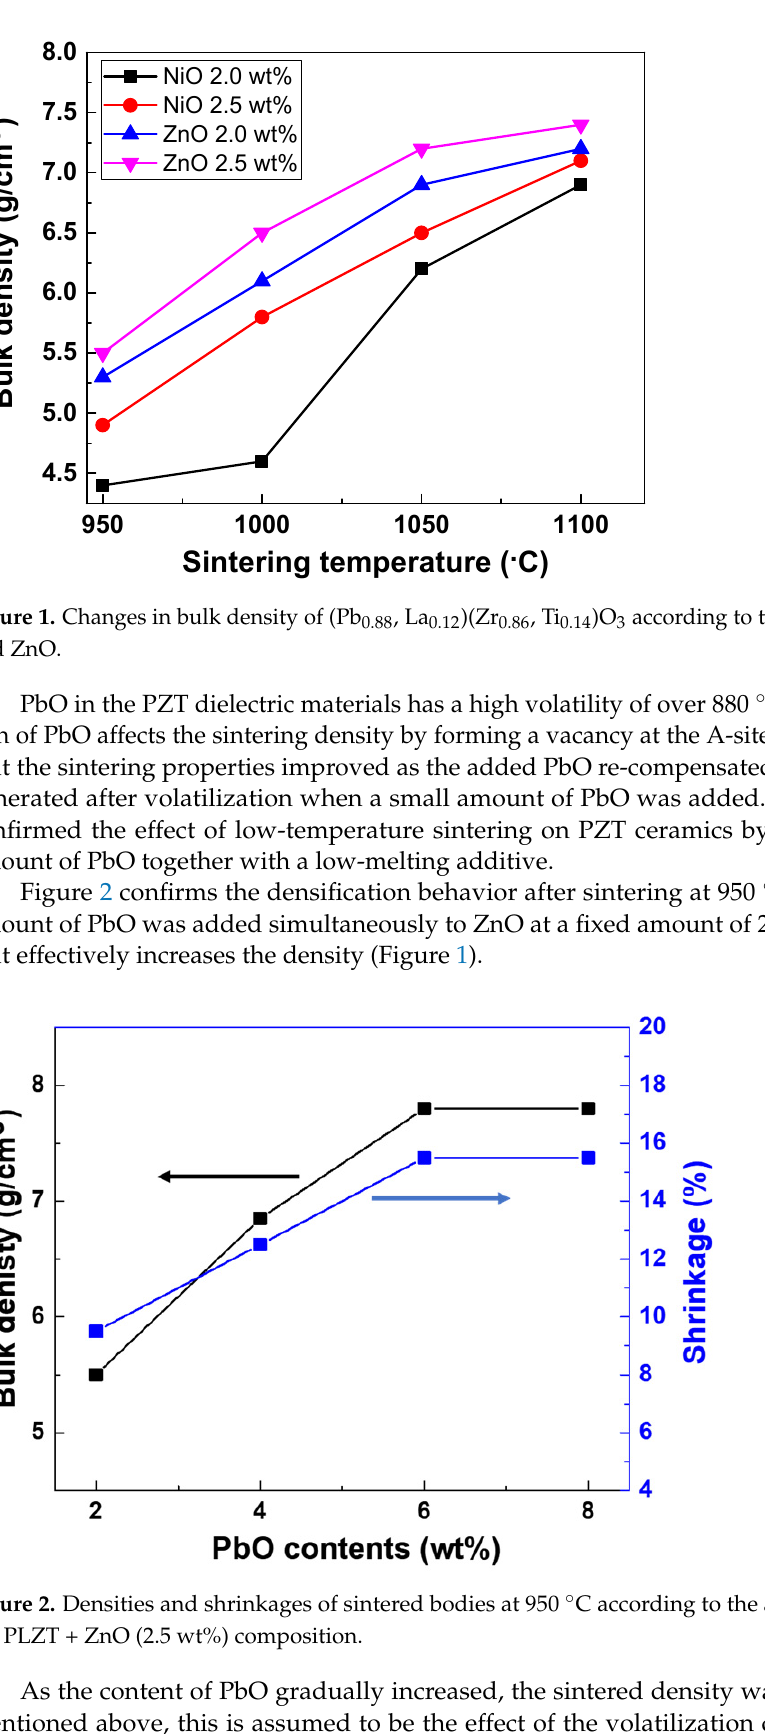
Figure 2. Densities and shrinkages of sintered bodies at 950 °C according to the addition of PbO in the PLZT + ZnO (2.5 wt%) composition. As the content of PbO gradually increased, the sintered density was improved. As mentioned above, this is assumed to be the effect of the volatilization compensation of PbO and liquefaction of ZnO. When more than 6 wt% of PbO was added, a density of 7.8 g·cm − 3 and a shrinkage rate of 15% was obtained. As a result, when ZnO and PbO were simultaneously added to the PLZT composition, the densification of PLZST was com- pletely formed at 950 °C. Based on the results in Figures 1 and 2, a composition containing 2.5 wt% of ZnO and 8.0 wt% of PbO was selected, and the change in sintering density at 950 °C was observed according to the amount of Sn 4+ substitution for Zr 4+ . In general, when an additive is